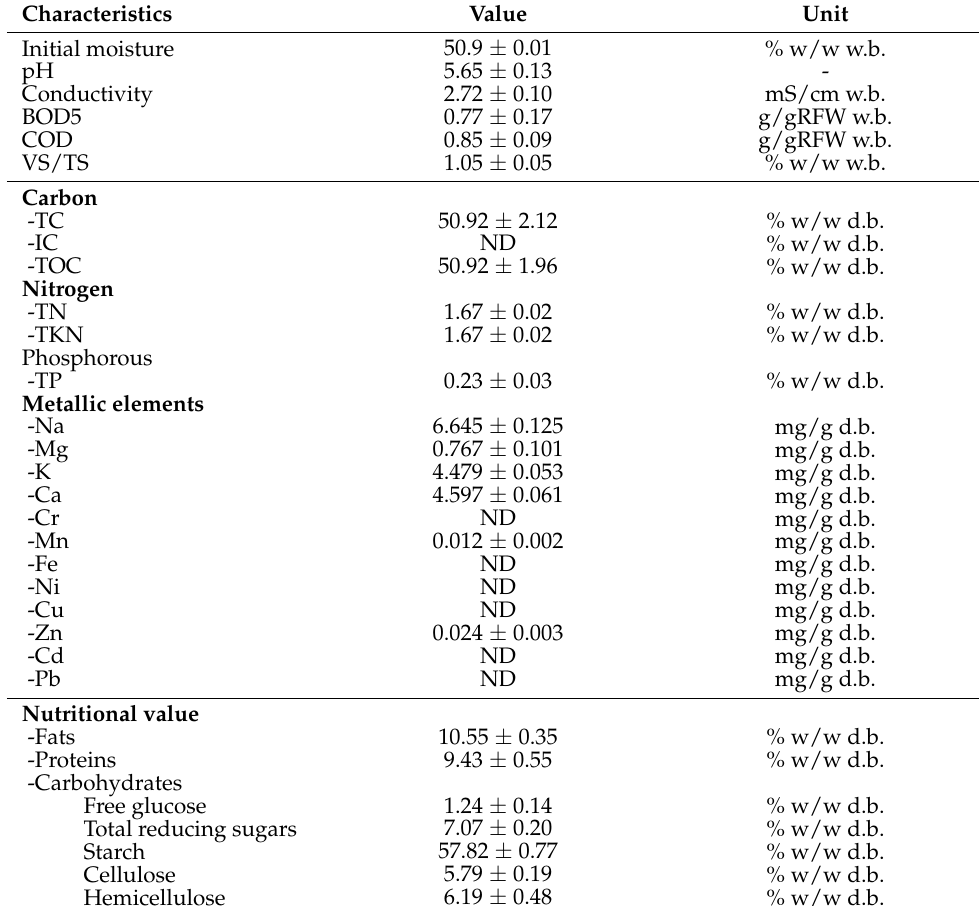
Table 1. Characteristics of the RFW considered in this study.